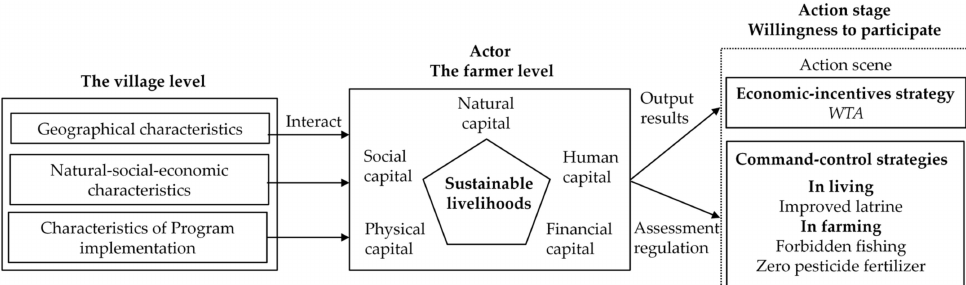
Figure 1. Schematic diagram of the simplified IAD